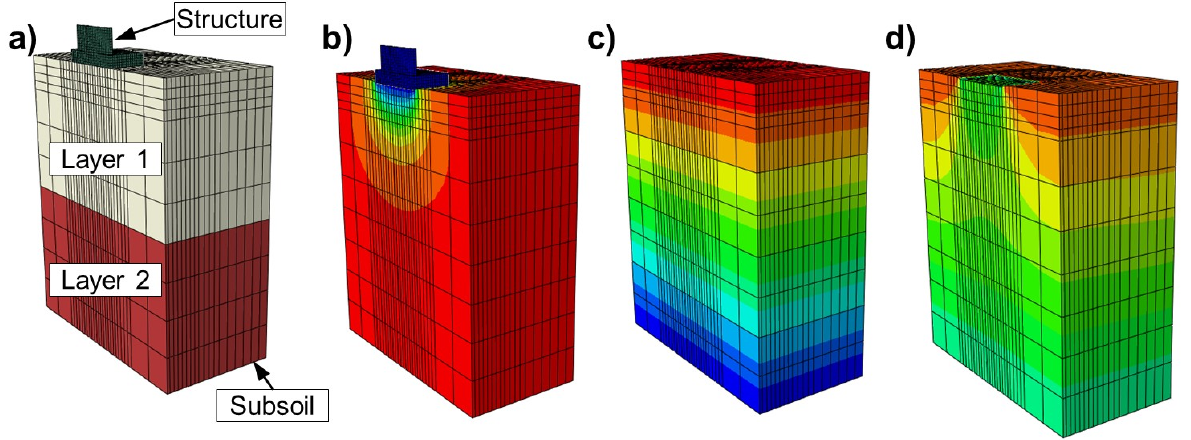
Figure 13. The partial model Z1—section of the building with the subsoil at the Z1 benchmark: ( a ) with division into layers, ( b ) vertical displacement map, ( c ) S33 stress map—“Geostatic” step, ( d ) S33 stress map—“Load 3” step.